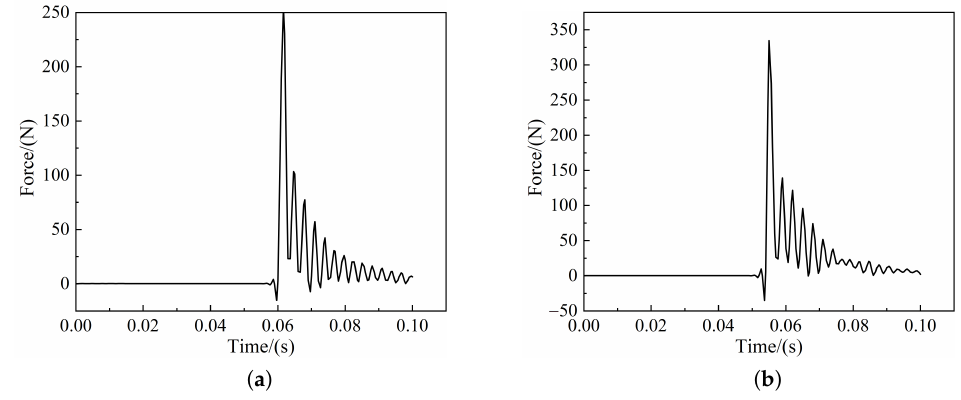
Figure 28. Anti-creeper force curveforce curve: ( a ) Cow head-on collision; ( b ) Cow offset